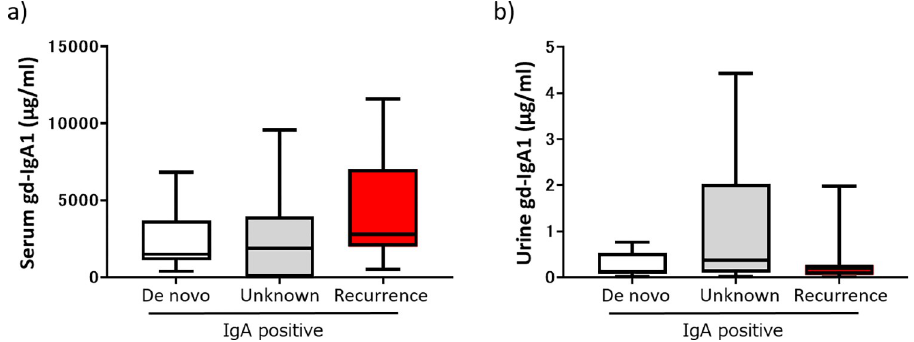
Fig 3. Serum and urinary Gd-IgA1 levels according to the original disease. a) Serum Gd-IgA1 levels. b) Urinary Gd- IgA1 levels. Gd-IgA1, galactose-deficient IgA1; IgA, immunoglobulin A.